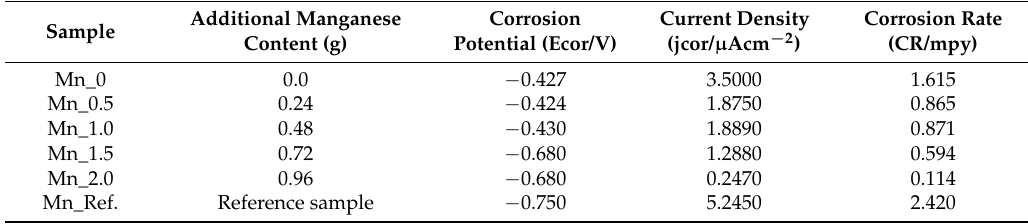
Table 8. The values of corrosion potential, current density, and corrosion rate estimated for the samples with Mn